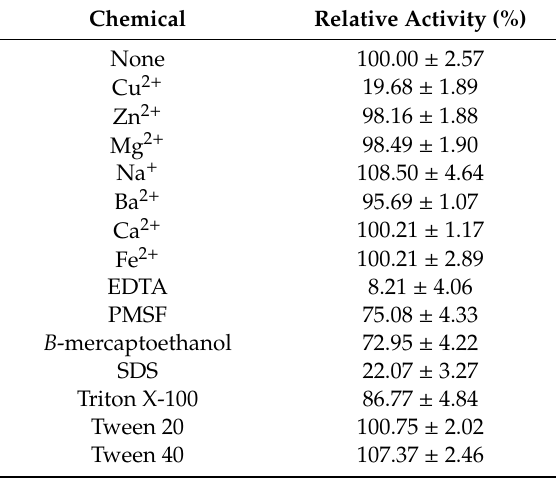
Table 4. E ff ect of various chemicals on the activity of the TKU032